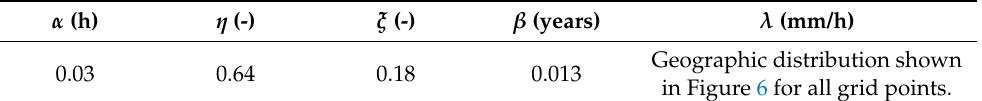
16 of 23 Figure 5. Empirical K-moments of the pooled standardized 24 h rainfall annual maxima sample, their theoretical values by the EV2 distribution and the corresponding return periods.